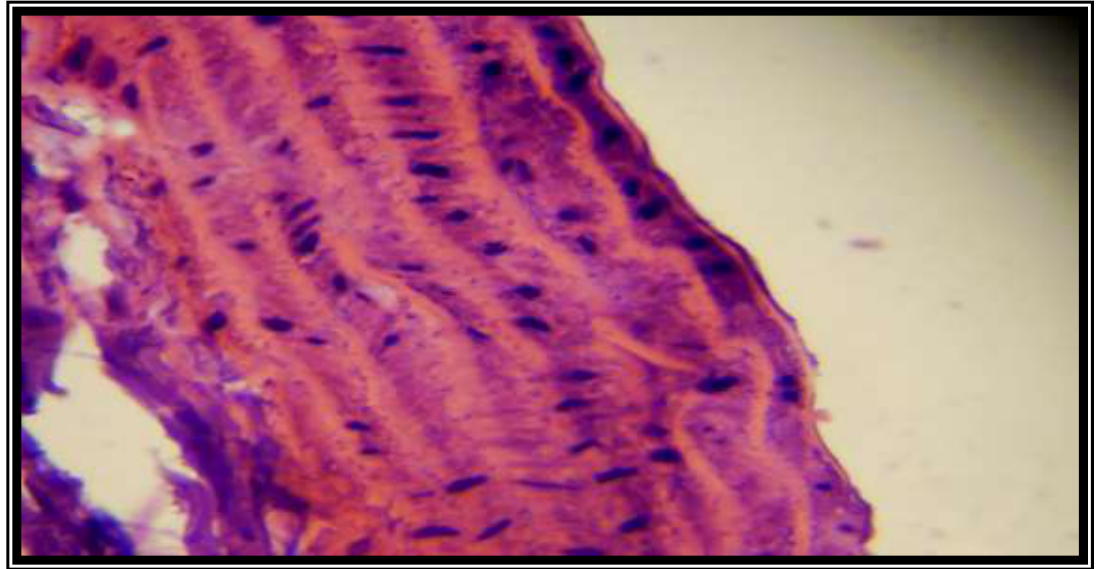
Figure (11) Histological section of aorta treated H2O2 Plus black currant concentrate complete regression of lesion in layer of its. H.E 40X.